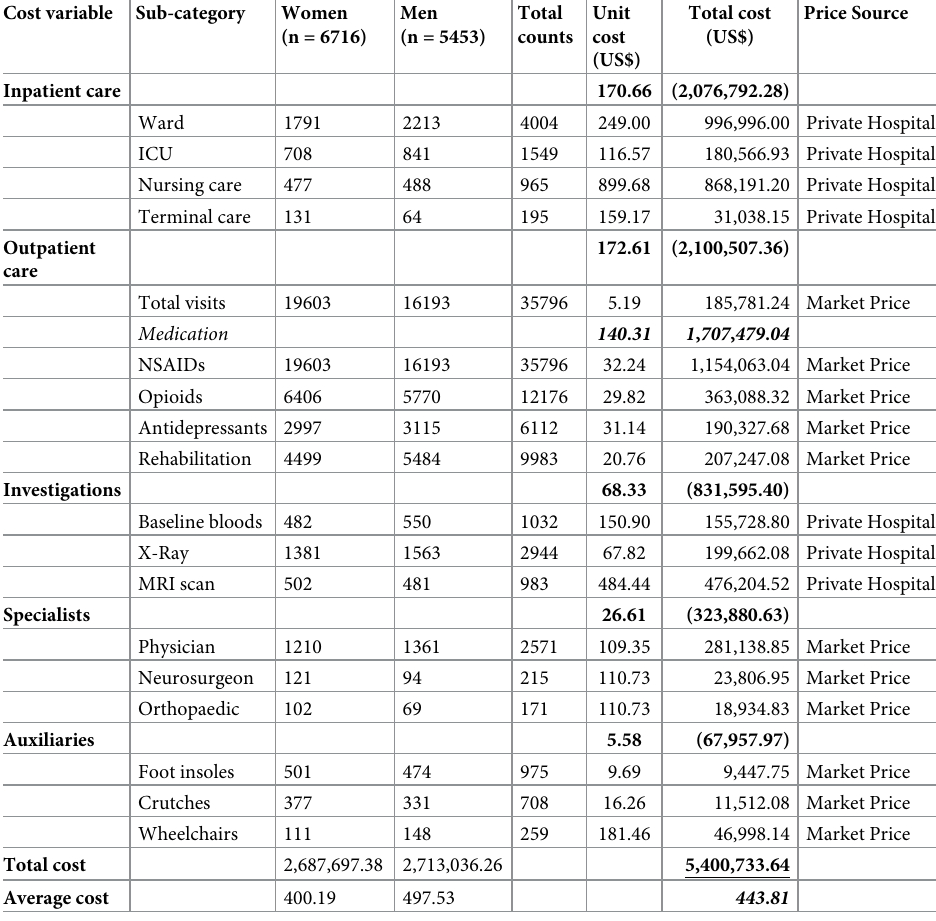
Table 4. Overall estimated cost low back pain in tertiary care (N =